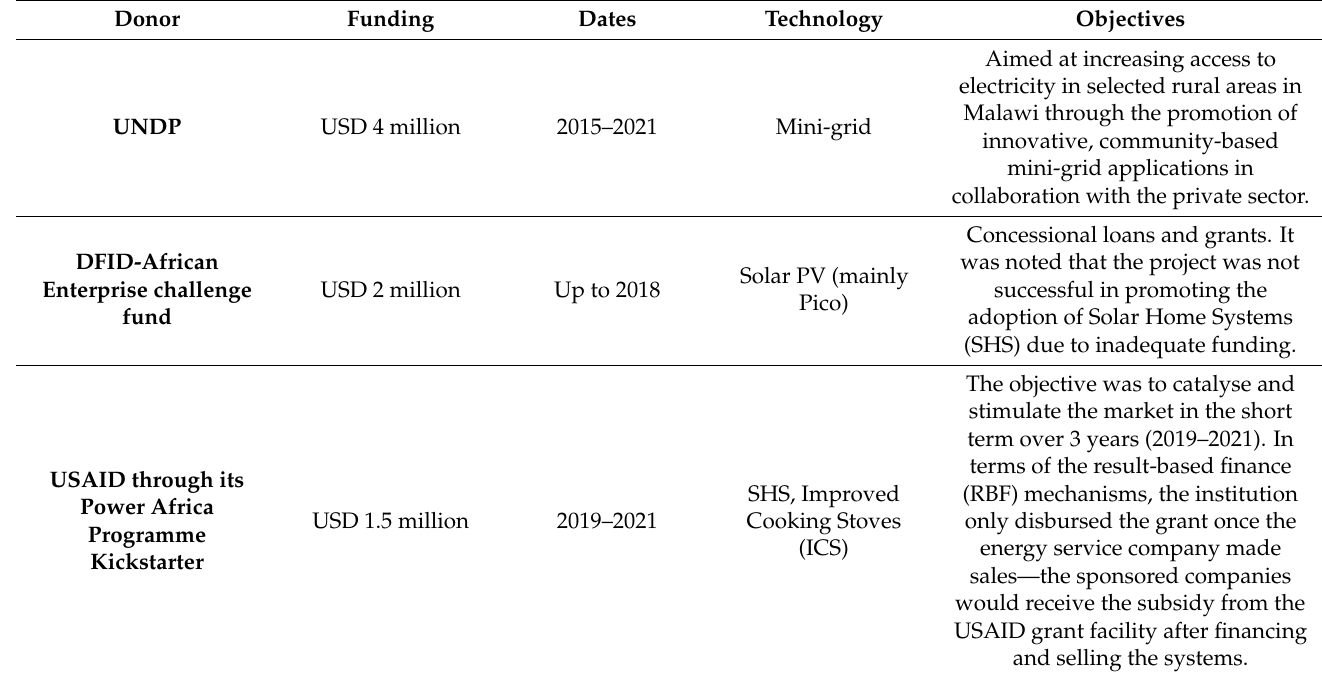
Table 2. List of off-grid and grid-connected renewable electricity projects aiming to support the acceleration of energy access in Malawi (adapted from